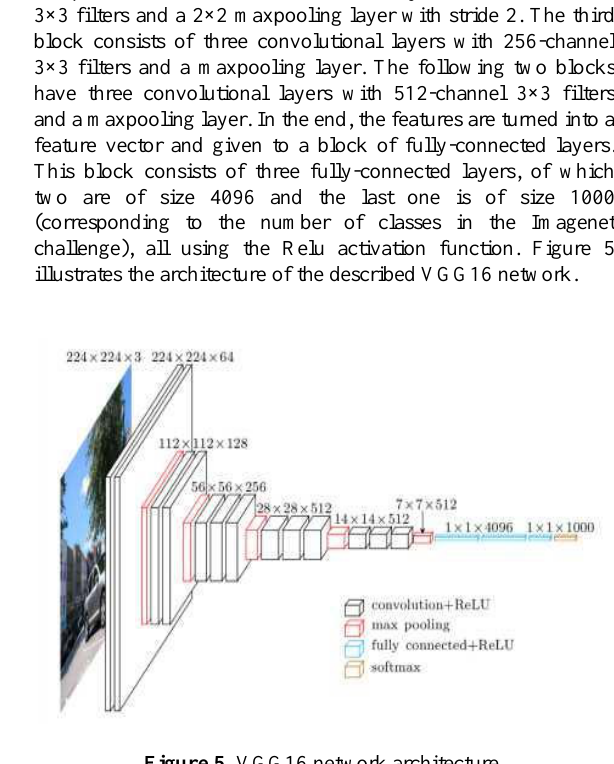
Figure 5 . VGG16 network architecture.